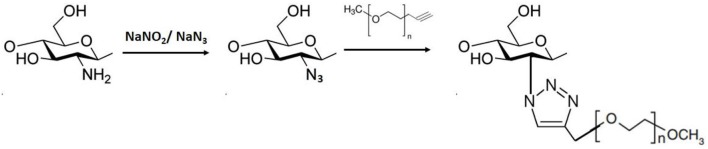
1,3-dipolar cycloaddition (adapted from Kulbokaite et al., 2009).